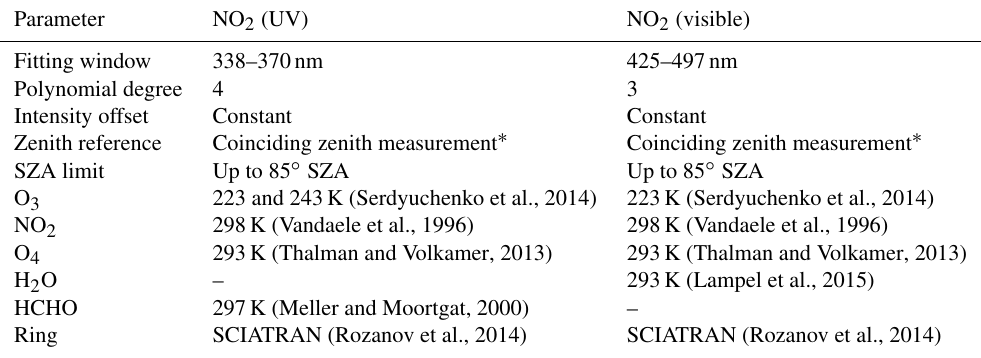
Table 1. DOAS fit settings for the retrieval of NO 2 and O 4 in UV and visible spectral ranges. Parameter NO 2 (UV) NO 2 (visible) Fitting window 338–370nm Polynomial degree 4 Intensity offset Constant Constant Zenith reference Coinciding zenith measurement ∗ Coinciding zenith measurement ∗ SZA limit Up to 85 ◦ SZA Up to 85 ◦